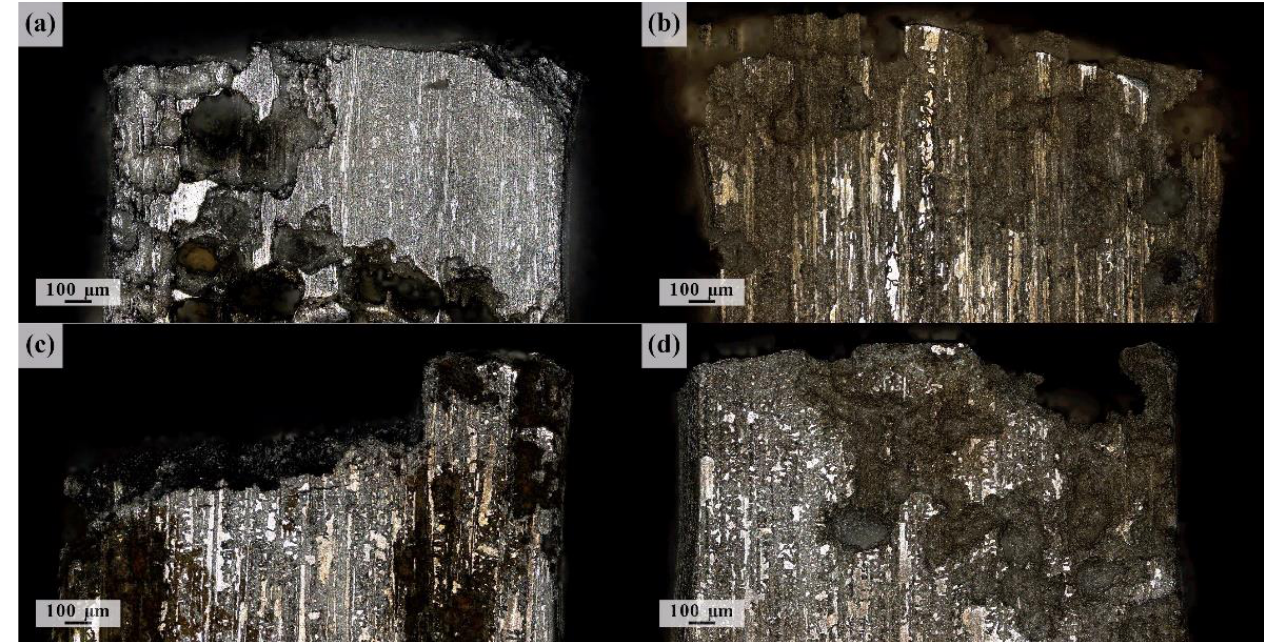
Figure 8. CLSM images of the side fracture surface of ZK60 specimens tested at 50 MPa stress amplitude after surface preparation by grinding ( a , c ) and polishing ( b , d ); ( a , b ) refer to the 10 Hz test frequency, ( c , d ) correspond to the 80 Hz frequency.